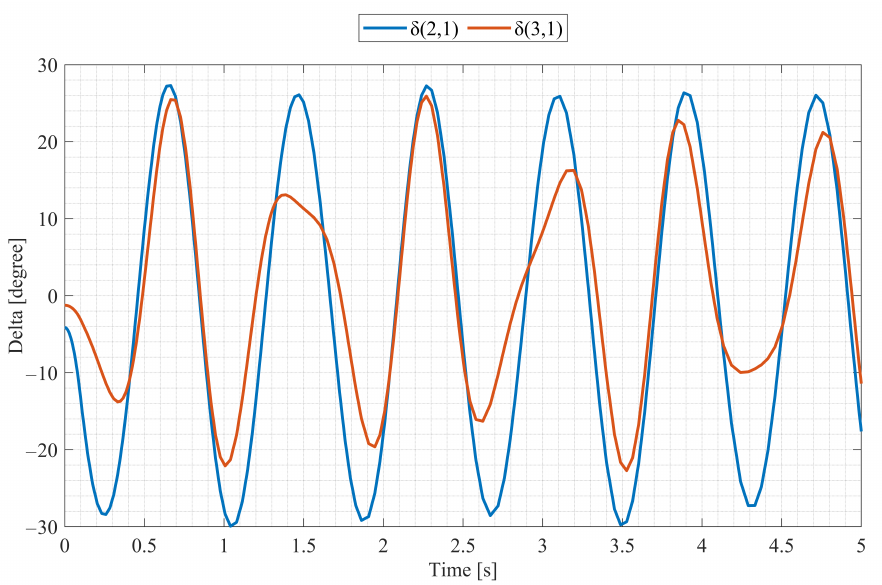
Figure 6. Generator angle oscillation, generator 1 is the reference in the IEEE 9-bar system.